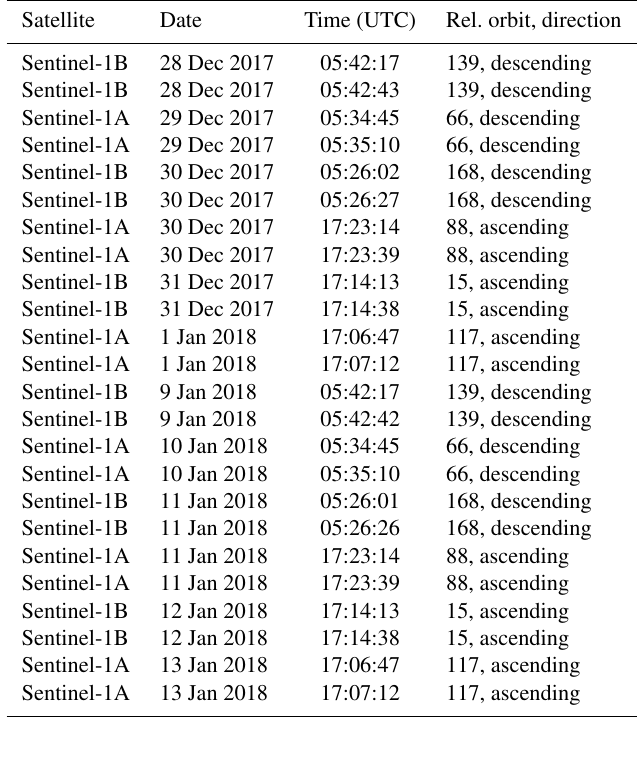
Table A1. List of S1 acquisitions used for the multiorbital change detection composite shown in Fig. 7.